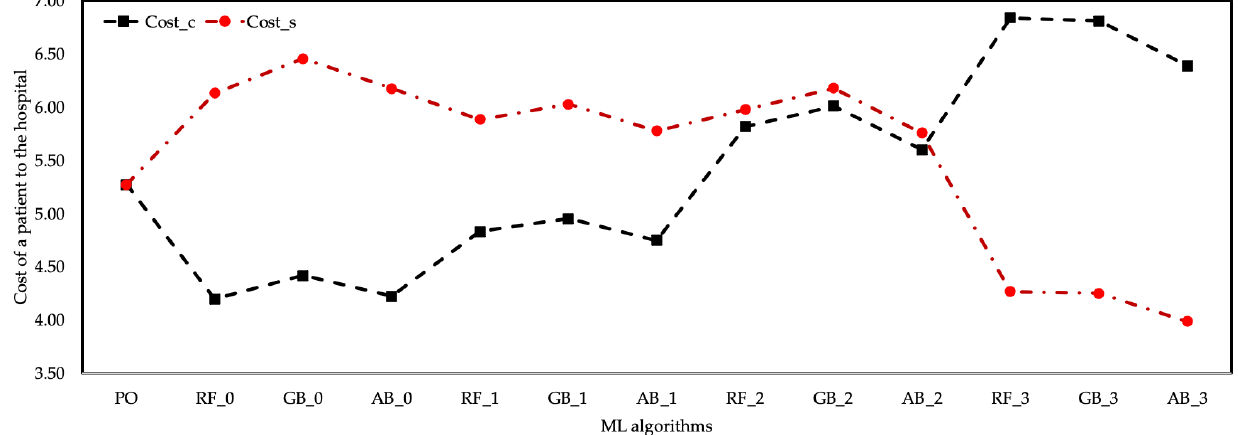
Figure 6. Cost of a patient to hospital according to δ i -based ML algorithms. Despite the increase in the cost of healthcare resources according to the δ 0.2 coefficient cost of this scenario to the hospital. The cost of healthcare resources remained below the cost of the hospital with the increase in the number of patients treated according to the δ 0.3 best cost performance of other